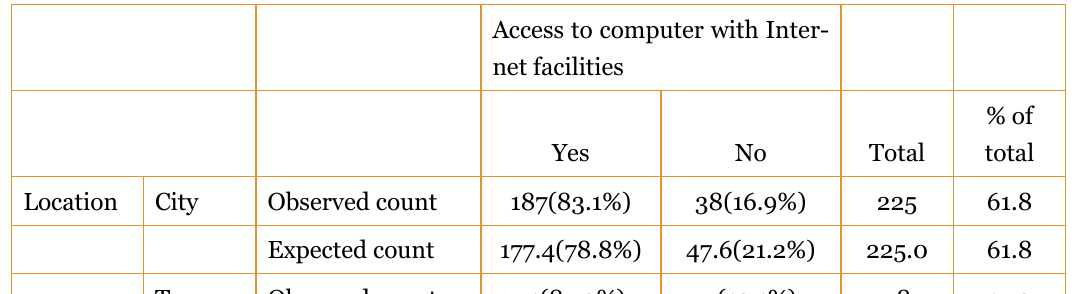
Location and Access to Computer with Internet Facilities